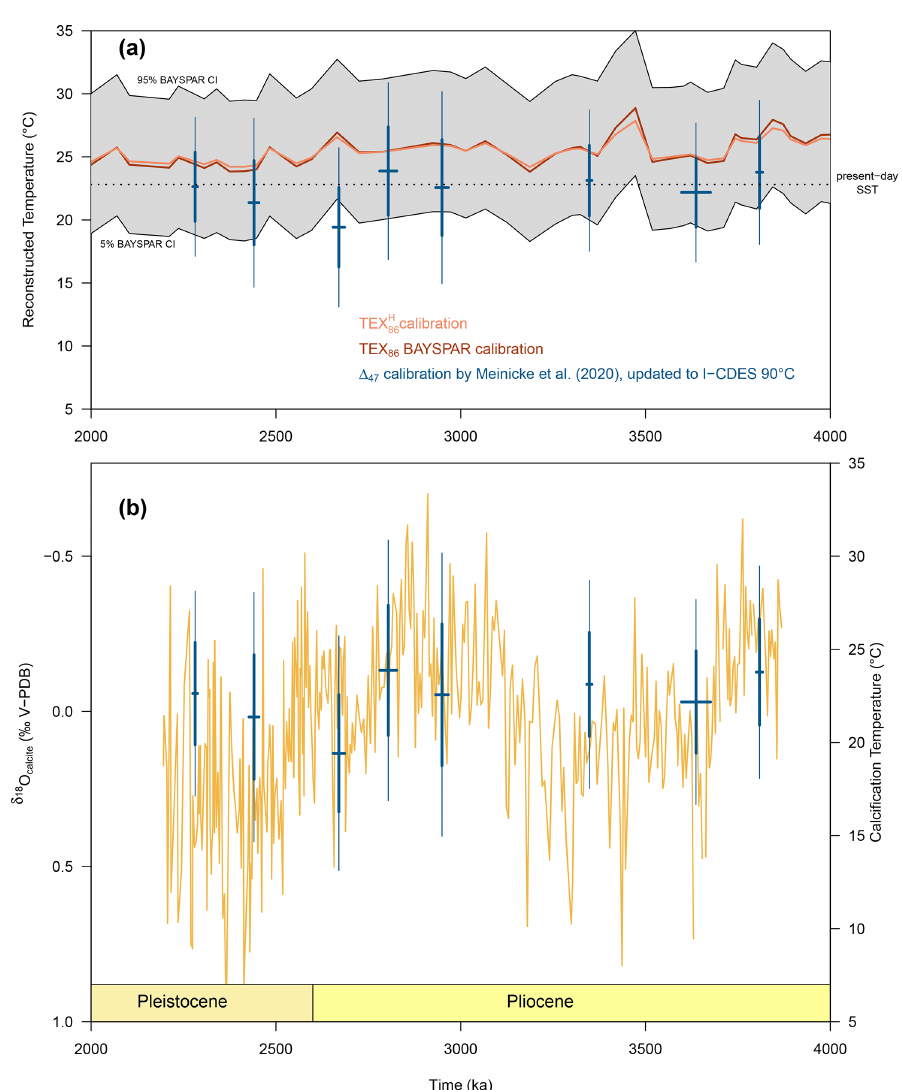
Figure 4. (a) Ocean temperature reconstructions based on TEX 86 (De Vleeschouwer et al., 2019b) and clumped isotopes (this study) are offset by about 3 ◦ C. Clumped-isotope error bars represent ± 68% (bold lines) and 95% confidence intervals (thin lines). (b) Comparison of U1459 clumped-isotope calcification temperatures and the planktic δ 18 O calcite time series. While clumped-isotope measurements quantify past ocean temperatures, the δ 18 O calcite time series allows for an investigation of past oceanographic variability on secular and astronomical